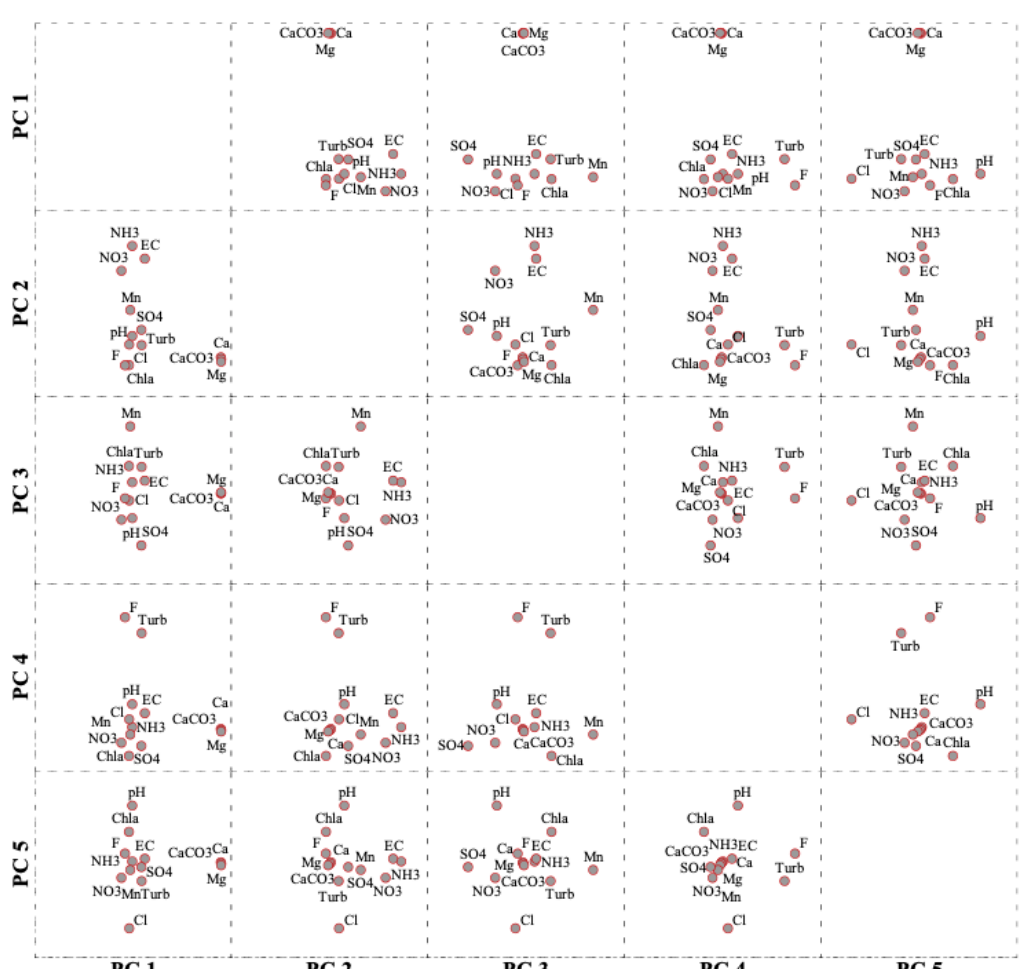
Figure 6. 2D biplot showing the relationship between highly correlated variables and the first five retained principal components (PCs). The five principal components (PCs) are denoted as PC 1, PC 2, PC 3, PC 4 and PC 5. Variables are ammonia (NH 3 ), calcium (Ca), chloride (Cl), chlorophyll-a (Chl-a), electrical conductivity (EC), fluoride (F), hardness (CaCO 3 ), magnesium (Mg), manganese (Mn), nitrate (NO 3 ), pondus Hydrogenium (pH), sulphate (SO 4 ) and turbidity (Turb). Source: PCA results from IBM SPSS Statistics [53].